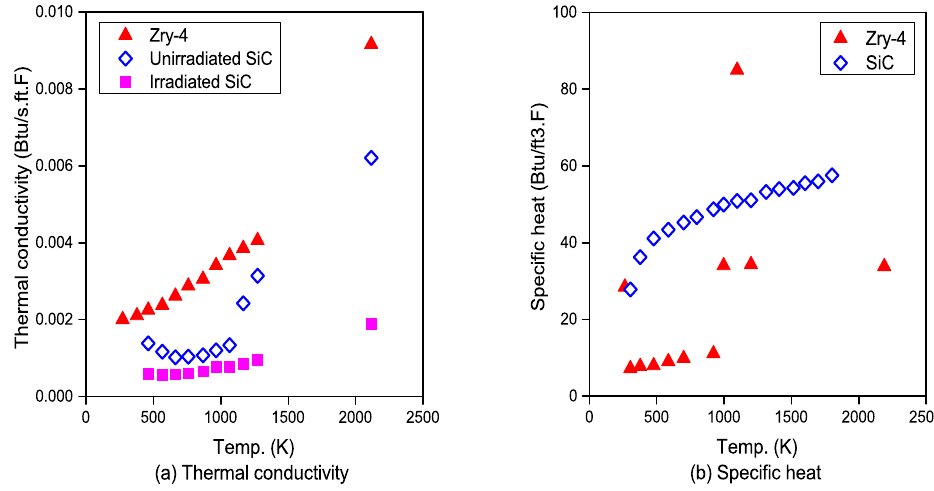
Figure 1. Input data in the RELAP5